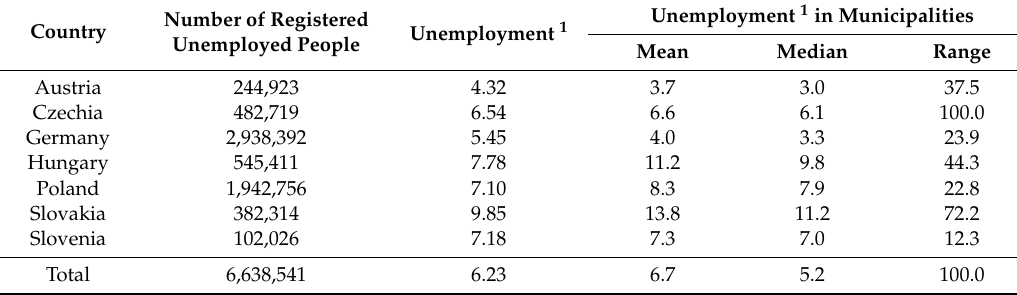
Table 2. Unemployment in studied